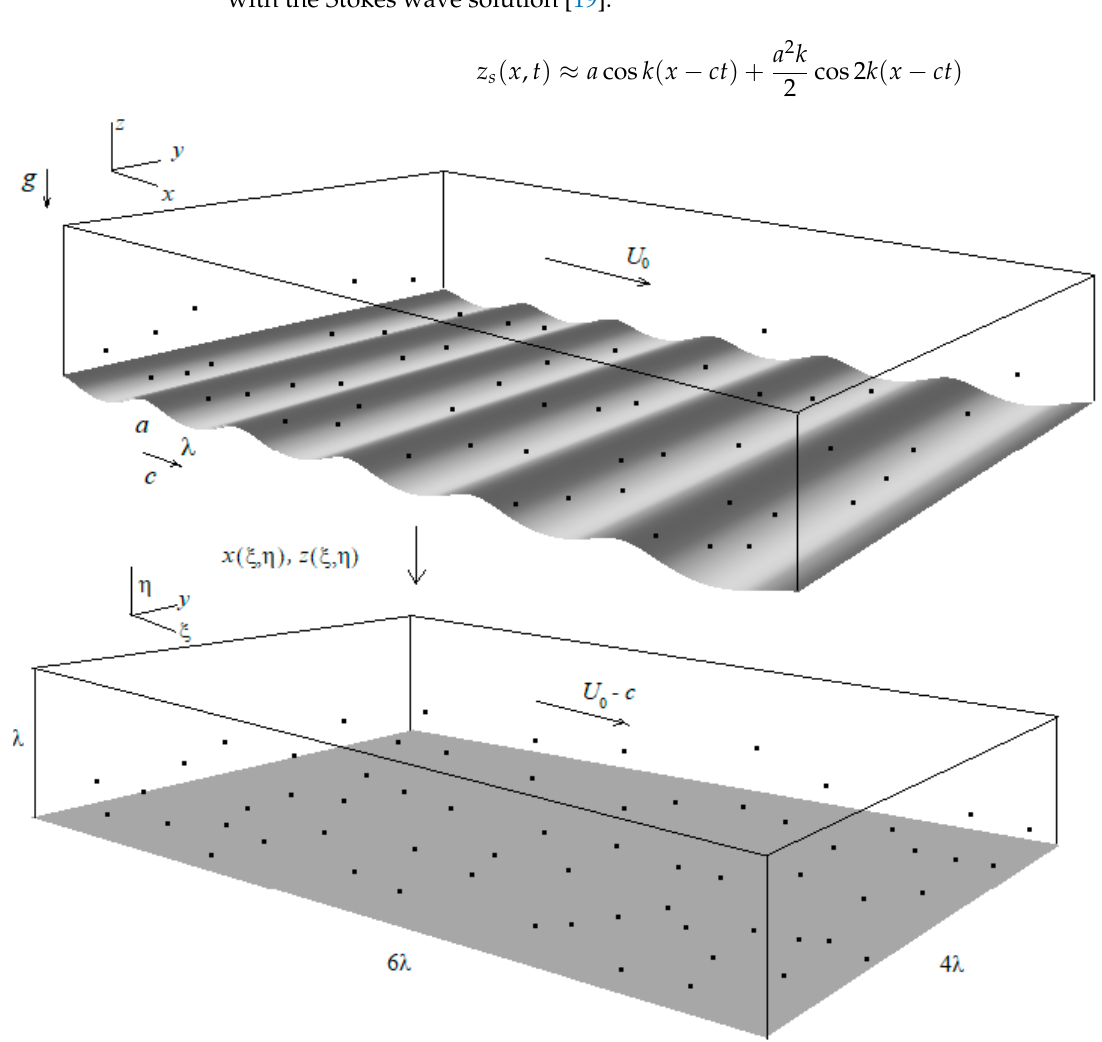
Figure 1. Schematic of the problem: the upper panel shows the physical domain where ( x , y , z ) are Cartesian coordinates; a , λ , c are the surface wave amplitude, length and celerity; g is the acceleration due to gravity. The physical domain is transformed by mapping (1) into the computational domain (lower panel) with a flat bottom employing curvilinear coordinates ( ξ , y , η ) and a reference frame moving in the wave propagation direction with velocity c . Symbols show injected droplets (not to scale).